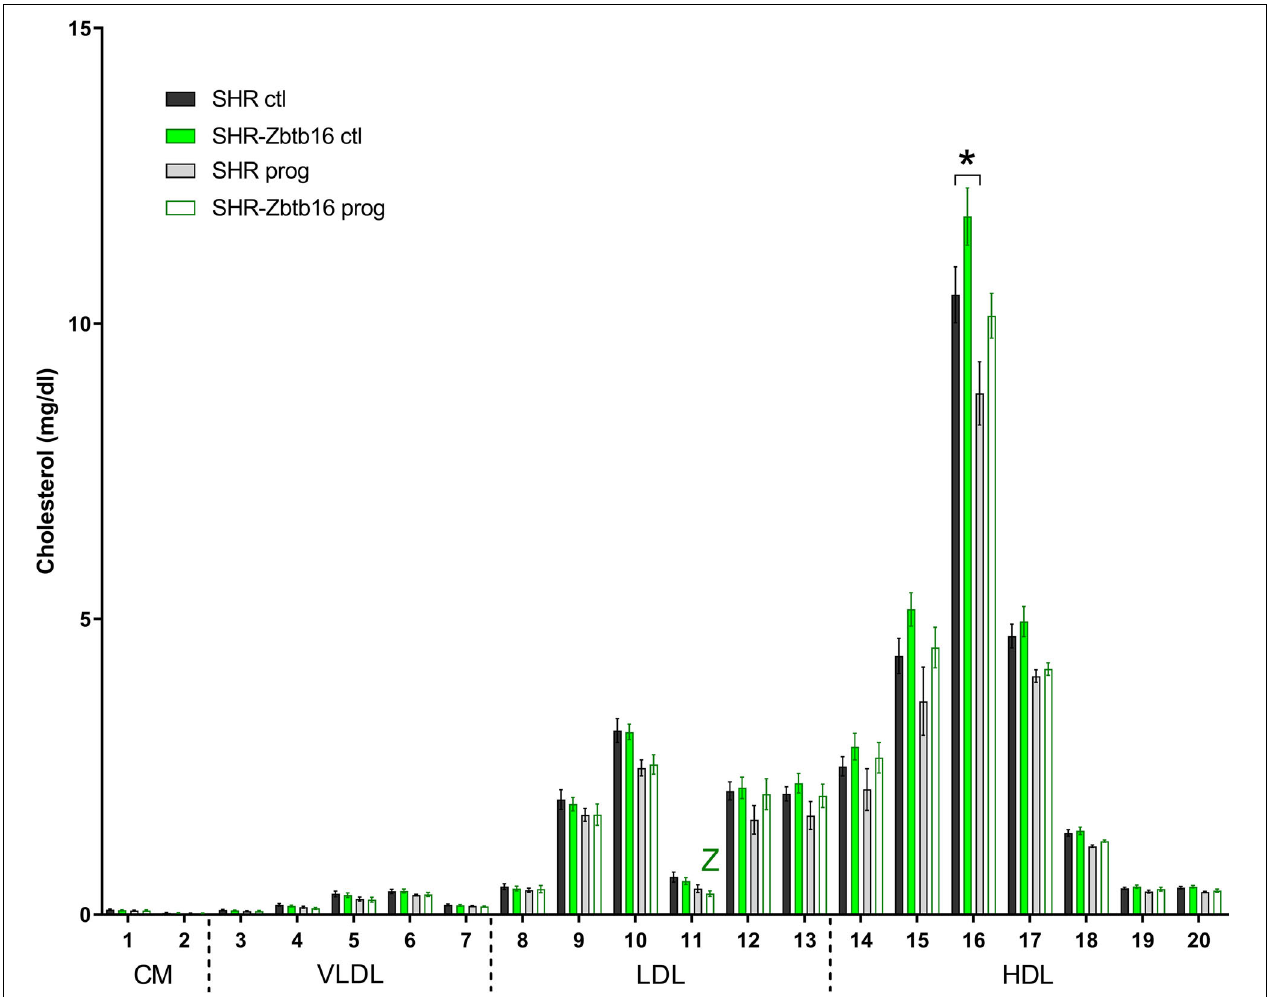
FIGURE 10 | Cholesterol lipoprotein profile. The cholesterol content in 20 lipoprotein subfractions in adult SHR control males (SHR ctl, black bars), SHR males programmed with maternal HSD (SHR prog, light gray bars), SHR- Zbtb16 control males (SHR- Zbtb16 ctl, green bars) and SHR- Zbtb16 males programmed with maternal HSD (SHR- Zbtb16 prog, empty green bars). The significance levels of pair-wise comparisons by post-hoc Fisher’s least significant difference test of the two-way ANOVA with STRAIN and MATERNAL DIET as major factors are indicated as follows: * p < 0.05, ** p < 0.01. Z represents differences in SHR- Zbtb16 : Ch11 ∗∗ between control and programmed males. The allocation of individual lipoprotein subfractions to major lipoprotein classes is shown in order of particle’s decreasing size from left to right. CM, chylomicron; VLDL, very low-density lipoprotein; LDL, low density lipoprotein; HDL, high density